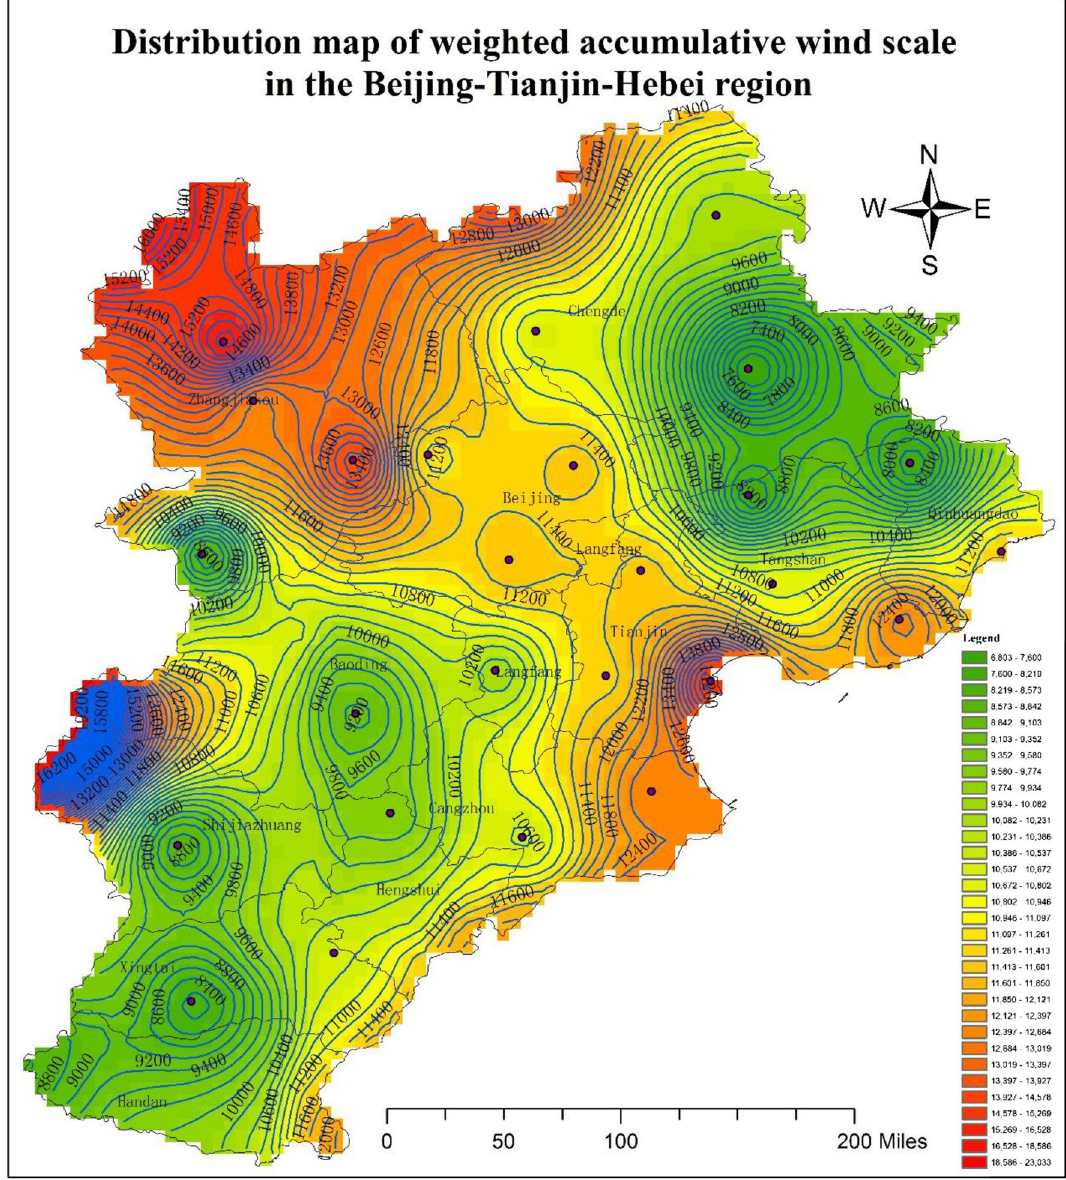
Figure 2. Distribution map of the weighted accumulative wind scale in the Beijing–Tianjin–Hebei region. The present map was done by using ArcGIS 10.0 desktop version (https ://www.esri.com/zh-cn/arcgi s/produ cts/arcgi s-pro/overv